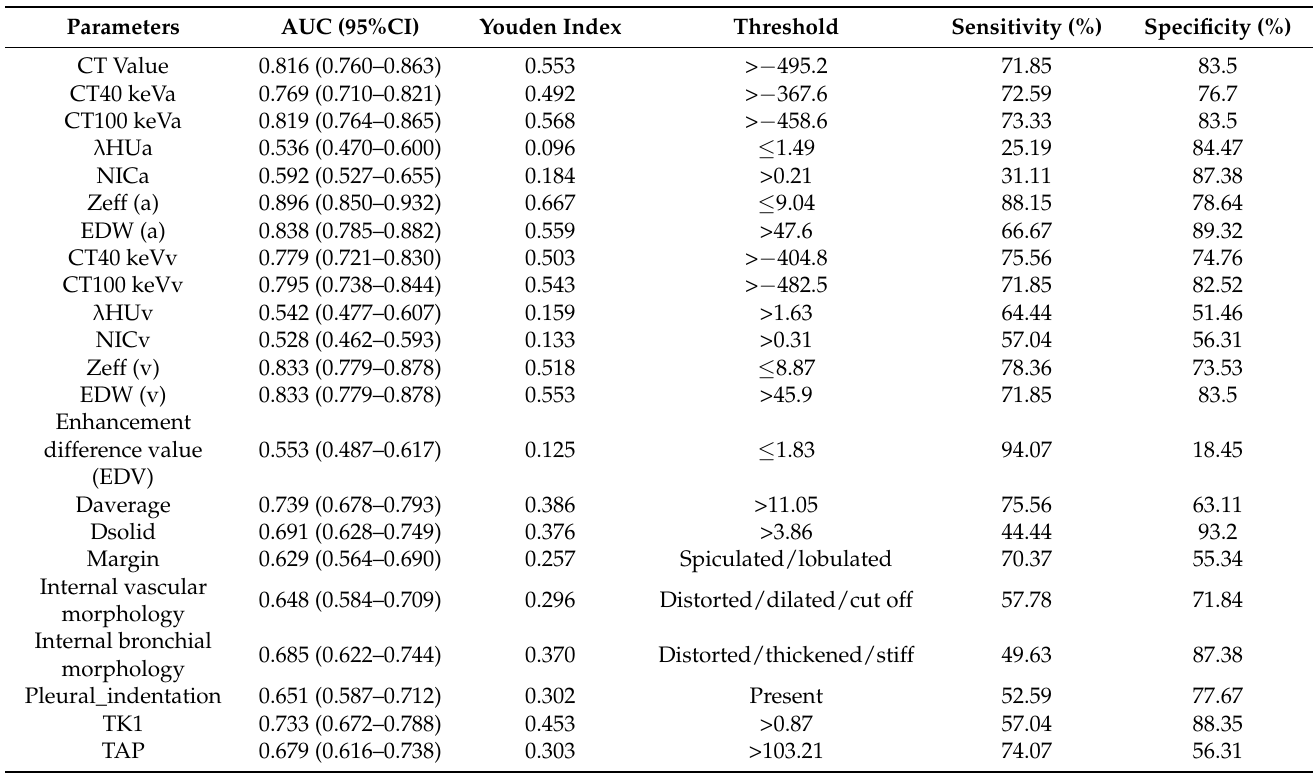
Table 4. The diagnostic efficiency of the parameters for distinguishing between precursor glandular lesions and